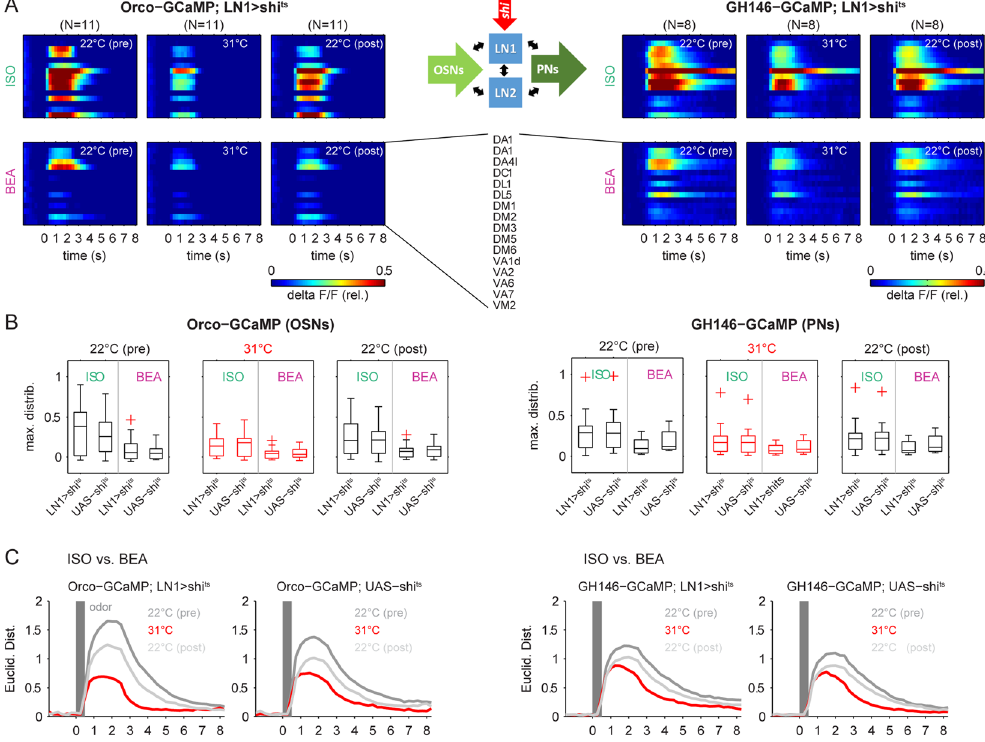
Figure 3. Silencing synaptic transmission of local interneurons type 1 (LN1). ( A ) Synaptic transmission of LN1 was silenced by expressing shi ts under the control of the enhancer trap line NP1227-GAL4 while calcium signals were monitored in OSNs (left: Orco) and PNs (right: GH146, see scheme part (ii) in Fig. 1 for details). False color coded mean activity of 15 glomeruli for the three experimental phases during the presentation of ISO (upper panels) and BEA (lower panels). ( B ) Comparison of the odor-evoked maximal fluorescence distributions between the parental control (UAS- shi ) and the experimental line (LN1 > shi ts ) reveals no significant differences between the permissive and non-permissive temperatures, neither for the OSN nor for the PN activity (ANOVA, p > 0.05). ( C ) The odor evoked population vector activity (shown in A) was used to calculate Euclidean distances between both odor representations separately in every experimental phase. The temperature increase to 31 °C led to a drastic decrease in the Euclidean distances (red) in OSN (left) as well as in PN activity (right). At the permissive temperature during the recovery phase, the Euclidean distances increased again but did not completely recover. However, we observed the same effect for the parental control (UAS- shi OSNs, N = 9; UAS- shi PNs, N =